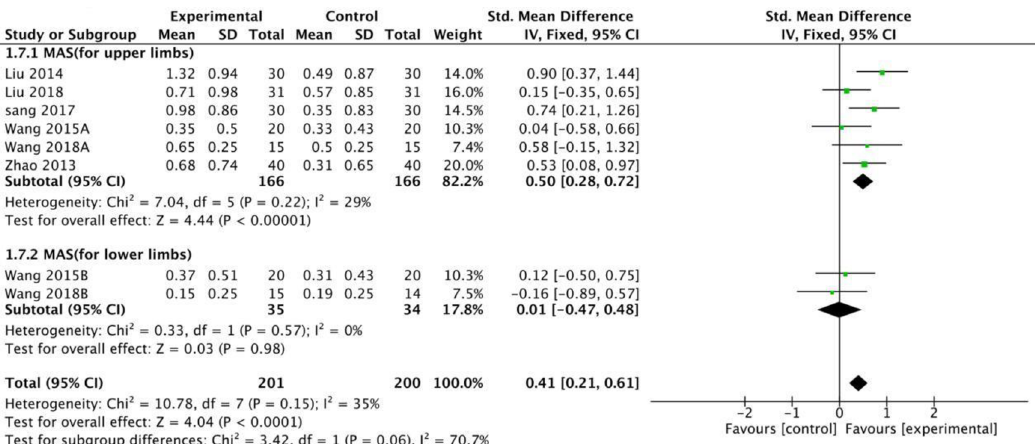
Fig 7. Meta-analysis of fire acupuncture versus acupuncture for spasticity after stoke according to region.